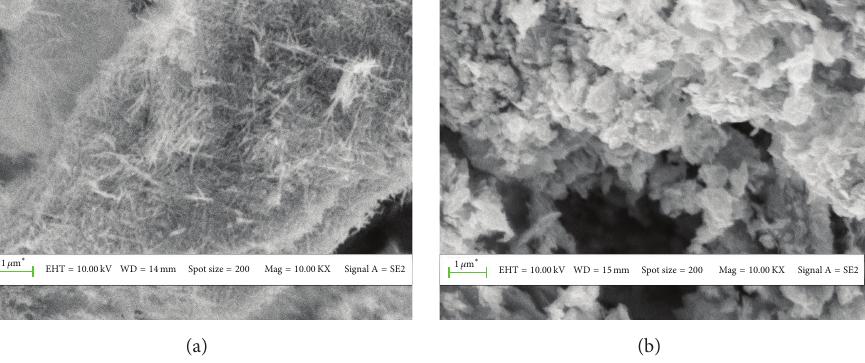
Figure 4: SEM images for (a) nickel oxide; (b) manganese oxide.